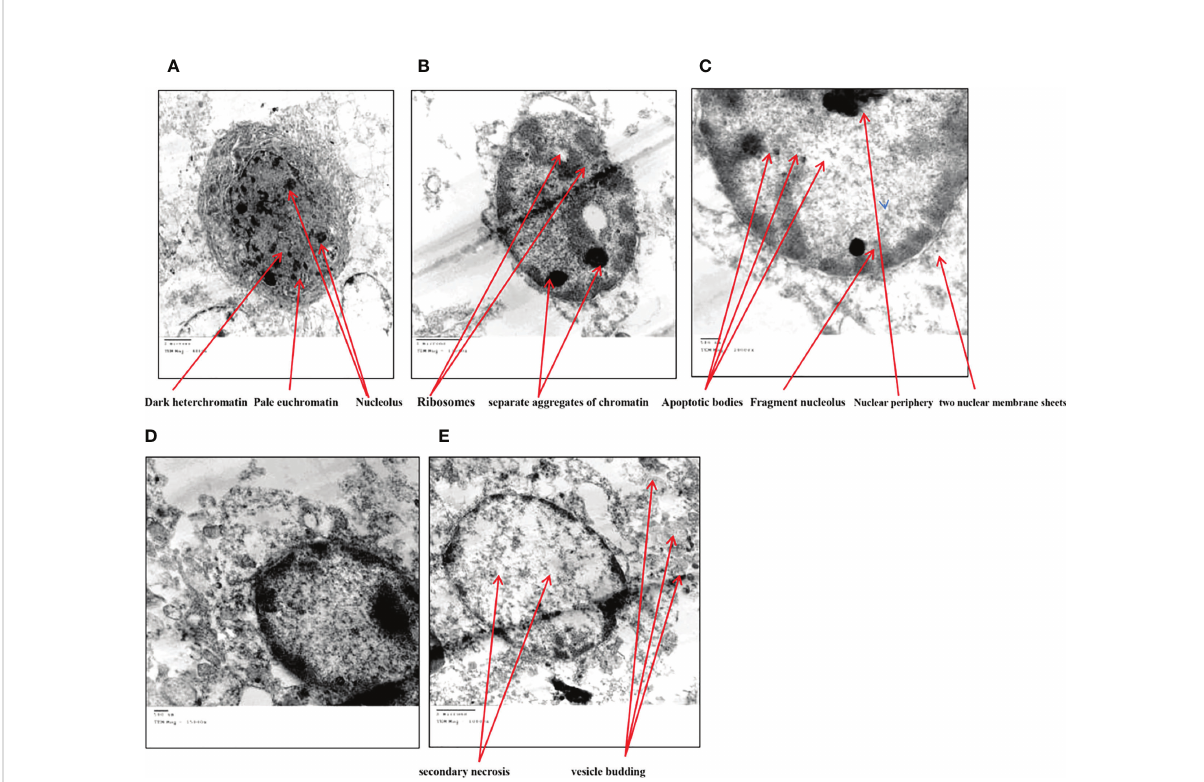
FIGURE 13 Transmission electron microscope of HuH7 exposed to 100 m g/ml of ZnO nanospheres (ZnO-NS) for 24 hour. (A) Control cell (B) Treated cell with to 100 m g/ml of ZnO nanospheres (ZnO-NS) for 3 hour. (C) Treated cell with to 100 m g/ml of ZnO nanospheres (ZnO-NS) for 6 hour. (D) Treated cell with to 100 m g/ml of ZnO nanospheres (ZnO-NS) for 12 hour. (E) Treated cell with to 100 m g/ml of ZnO nanospheres (ZnO-NS) for 24 hour.